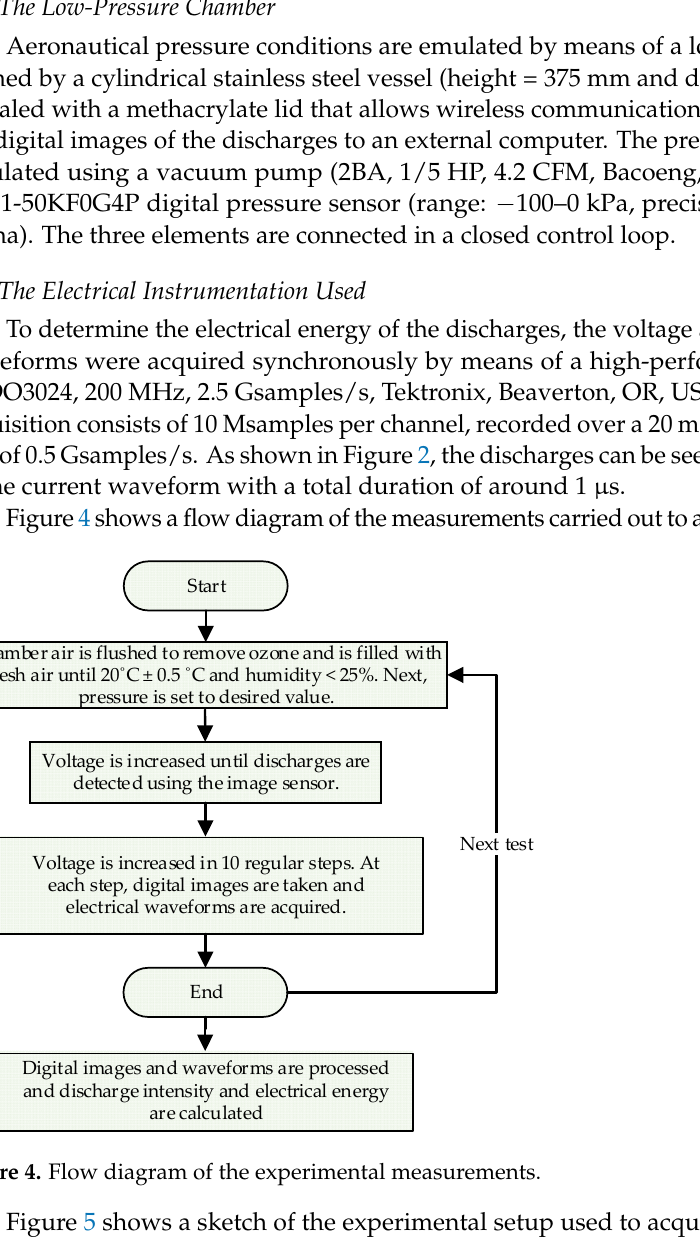
Figure 5. Sketch of the experimental setup. Variable frequency high-voltage was generated by connecting a programmable ac source (SP300VAC600W, 15–1000 Hz, 0–300 V, ±0.1 V, APM Technologies, Dongguan, China) to a single-phase transformer (VKPE-36, 1:100, 36 kV, Laboratorio Electrotécnico, Cornellà de Llobregat, Spain). The voltage was measured using a high-voltage probe (CT4028, 0 ‒ 39 kV peak , 1000:1, accuracy better than 3%, dc to 220 MHz, Cal Test Electronics, Yorba Linda, CA, USA).